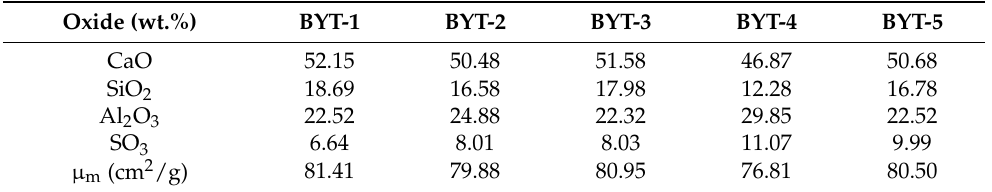
Table 3. The chemical composition and µ m value of BYT clinkers. Oxide (wt.%)